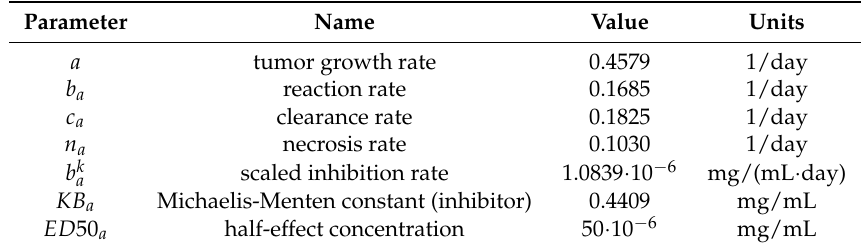
Table 1. Identified averaged values from mice as reported in [18] for Bevacizumab antiangiogenic treatment. Parameter Name Value Units a tumor growth rate 0.4579 reaction rate clearance